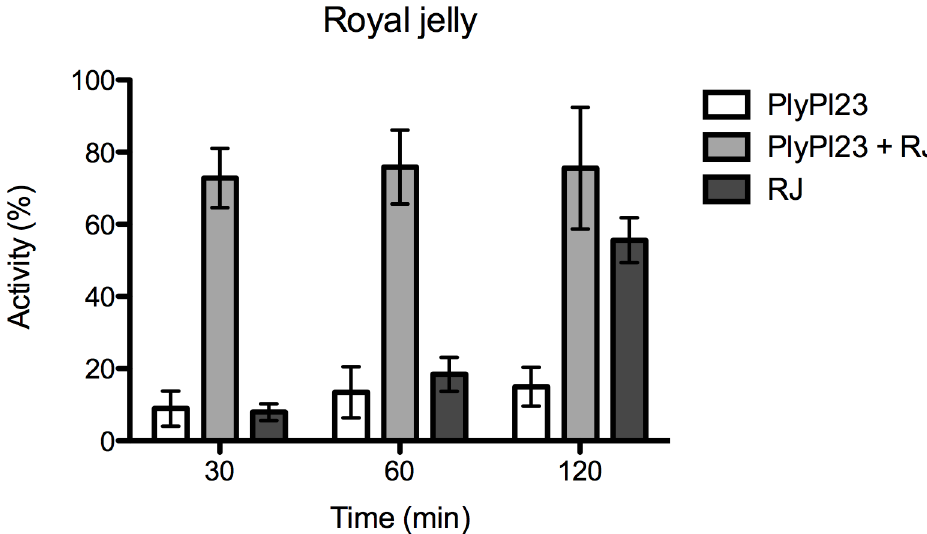
Fig 4. Effect of RJ on PlyPl23 activity. Activity of the enzyme after incubation in RJ for 1 h at 37°C. Results were recorded at 30, 60 and 120 min. Each column represents the mean of triplicate experiments and error bars indicate the standard